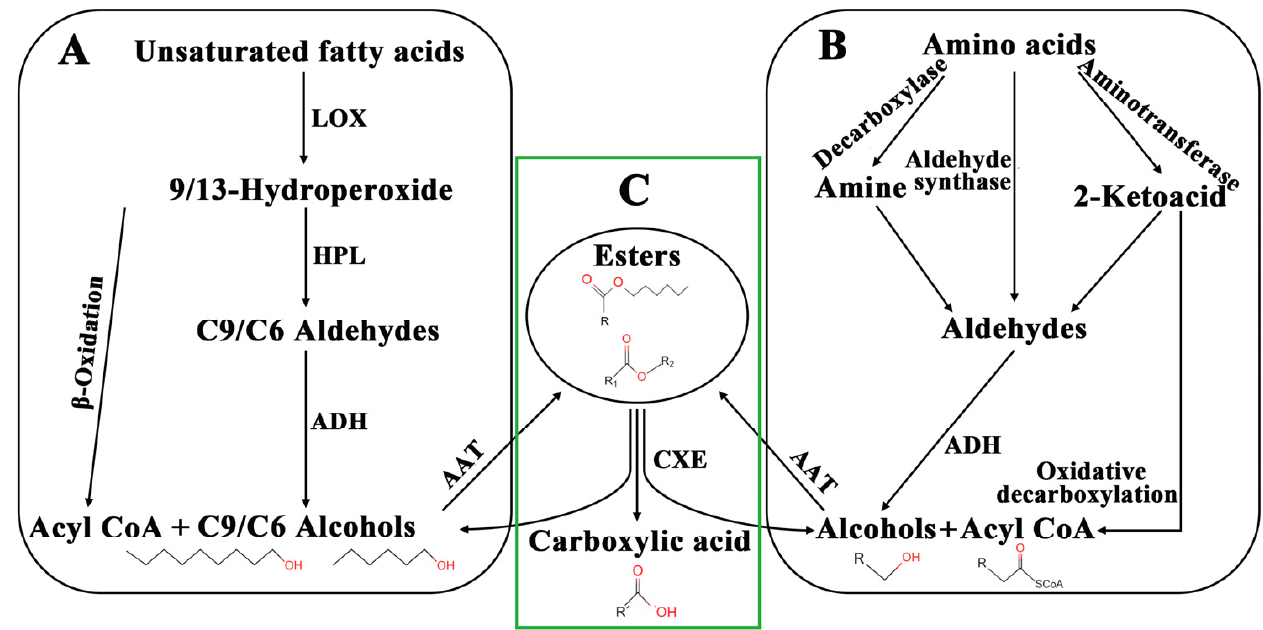
Figure 1. Metabolic pathway of volatile esters in strawberry. ( A ) Fatty acid pathway. ( B ) Amino acid pathway. ( C ) CXE pathway. LOX, lipoxygenase; HPL, hydroperoxide lyase; ADH, alcohol dehydro- genase; AAT, alcohol acyltransferases.